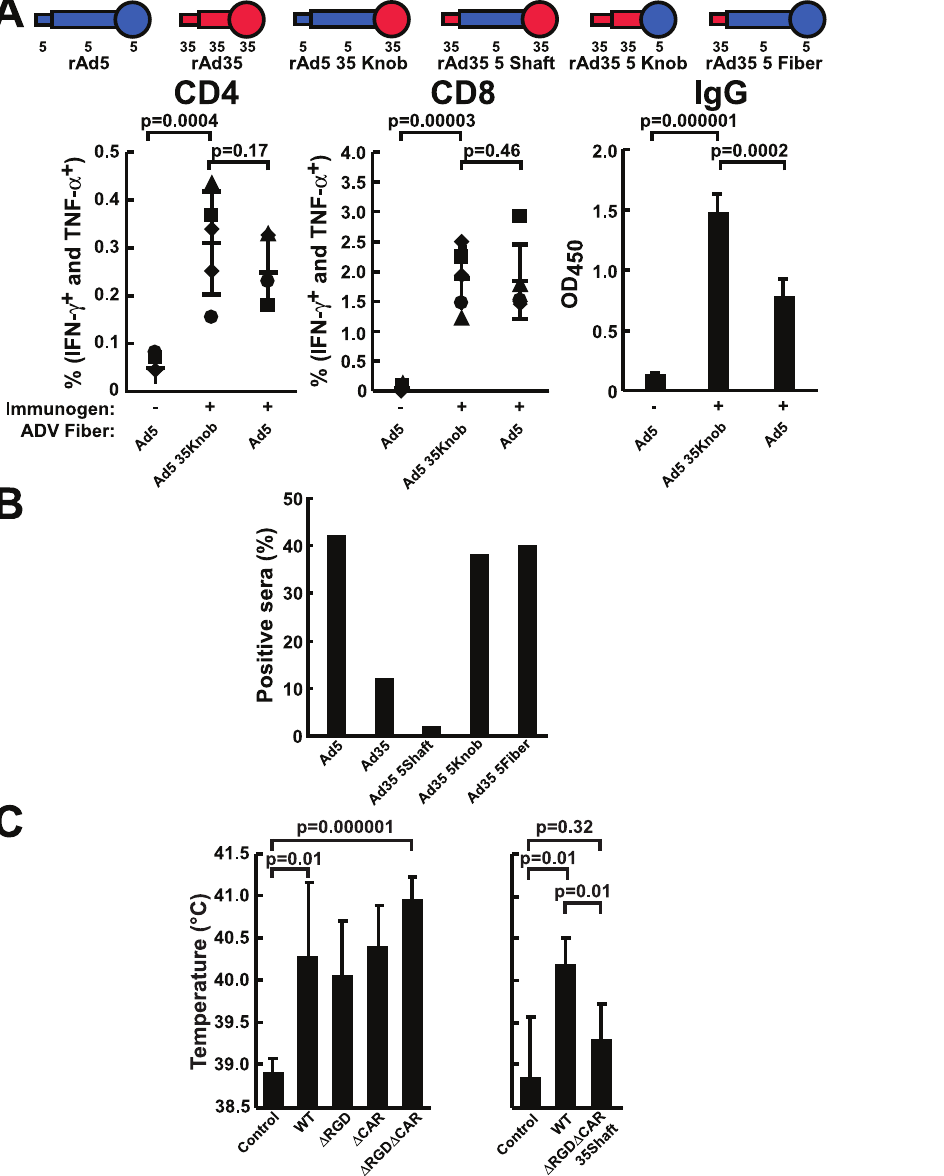
Figure 4. Ad5 Shaft Does Not Contain Human Neutralization Epitopes and Contributes to In Vivo Immunogenicity and Pyrogenicity of rAd5 Vector (A) Mice were injected with rAd5 or a chimeric rAd5 containing the knob region from Ad35 at 10 10 viral particles (Ad5 35knob). Cellular immune responses were assessed by analysis of intracellular cytokine staining in CD4 þ or CD8 þ cells, and antibody responses were assessed by ELISA in the same animals ( n ¼ 5). The samples were also stimulated with an irrelevant peptide pool derived from Ebola virus glycoprotein (Figure S3). (B) Neutralization of rAd vectors with 100 individual human sera. Recombinant Ad vectors with chimeric rAd5-rAd35 fiber proteins were incubated with serum diluted 1:12 for 1 h and added to the cells, and the GFP fluorescence intensity arising from infection was determined by flow cytometry. Sera that inhibited GFP expression by more than 50% were considered positive for neutralization. (C) Pyrogenicity of rAd5 vectors evaluated in rabbits. Rabbits were injected intramuscularly with 10 12 particles of the indicated rAd5-luciferase vectors, and body temperature was measured at 24 h postinjection for each animal ( n ¼ 5 for all the groups except n ¼ 3 in the control group of the right graph). The control groups were injected with the storage and dilution buffer for rAd vectors. The rAd5 vectors in the left panel had WT Ad5 capsid proteins (WT), a deletion of the RGD motif in the penton base protein ( D RGD), a mutation in the fiber knob that prevented CAR binding ( D CAR), or both capsid protein mutations ( D RGD D CAR). The two rAd5 vectors in the right panel were the WT capsid vector (WT) and a D RGD D CAR vector with the Ad5 shaft region replaced with the Ad35 shaft region ( D RGD D CAR